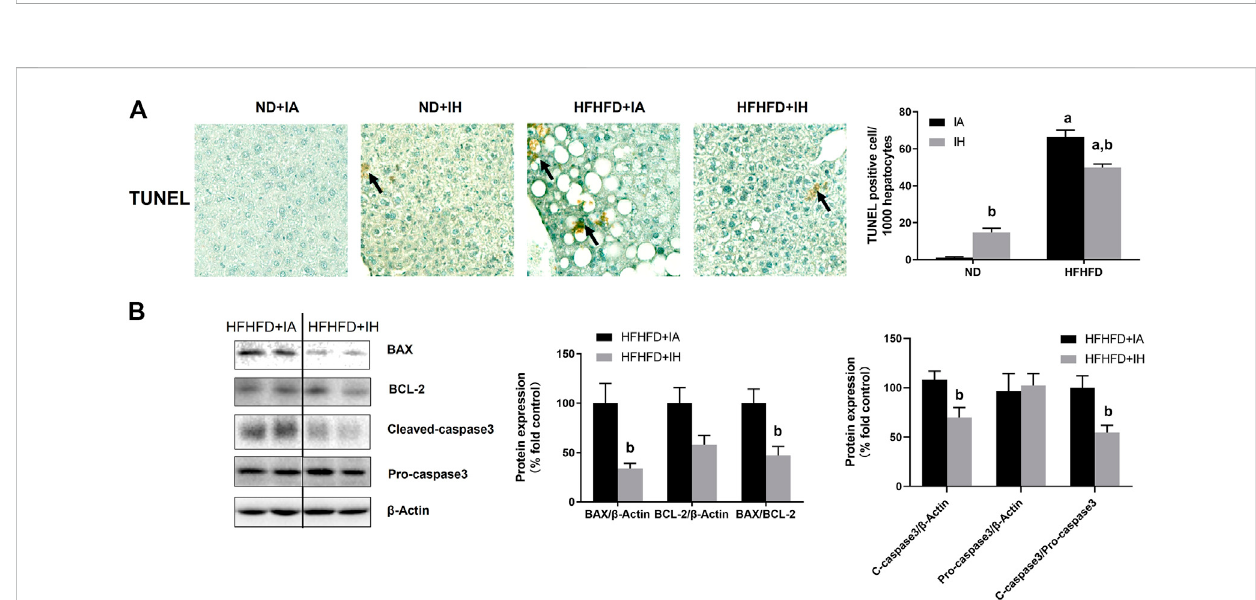
FIGURE 7 IH alleviated liver apoptosis in HFHFD-fed mice. (A) TUNEL staining was performed for the 15-week samples as presented by photomicrographs (magni fi cation×200).TUNEL-positivecellswerequanti fi edandareexpressedasTUNEL-positivecellsper1,000hepatocytes. (B) Representativewestern blotsanddensitometricanalysisforwholeliverCaspase-3, BAX,andBCL-2proteinareshown.a, p < 0.05comparedtoNDcontrol,b, p < 0.05compared to absence of IH. Samples size per group n = 4 –